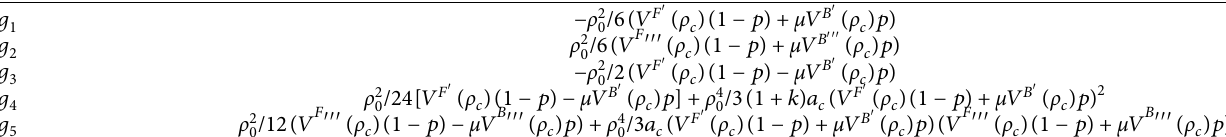
Table 1: The coefficients of equation